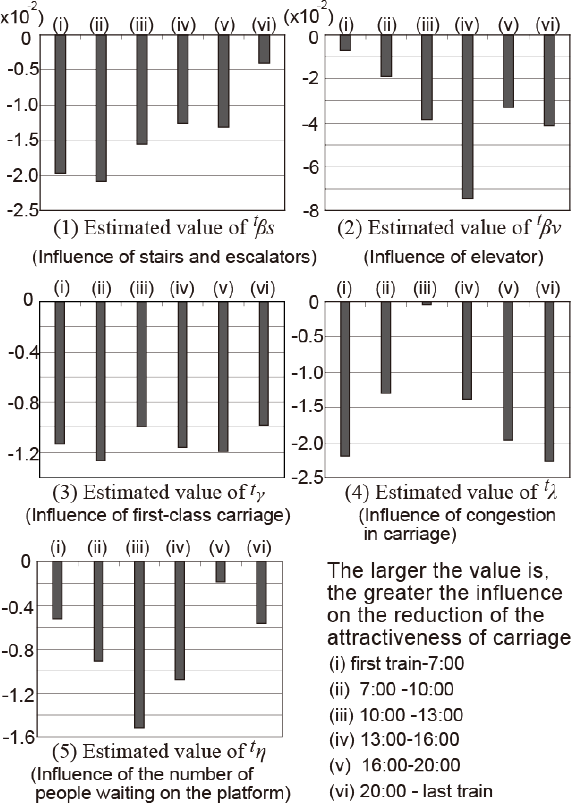
Figure 4 . Values of the estimated parameters.